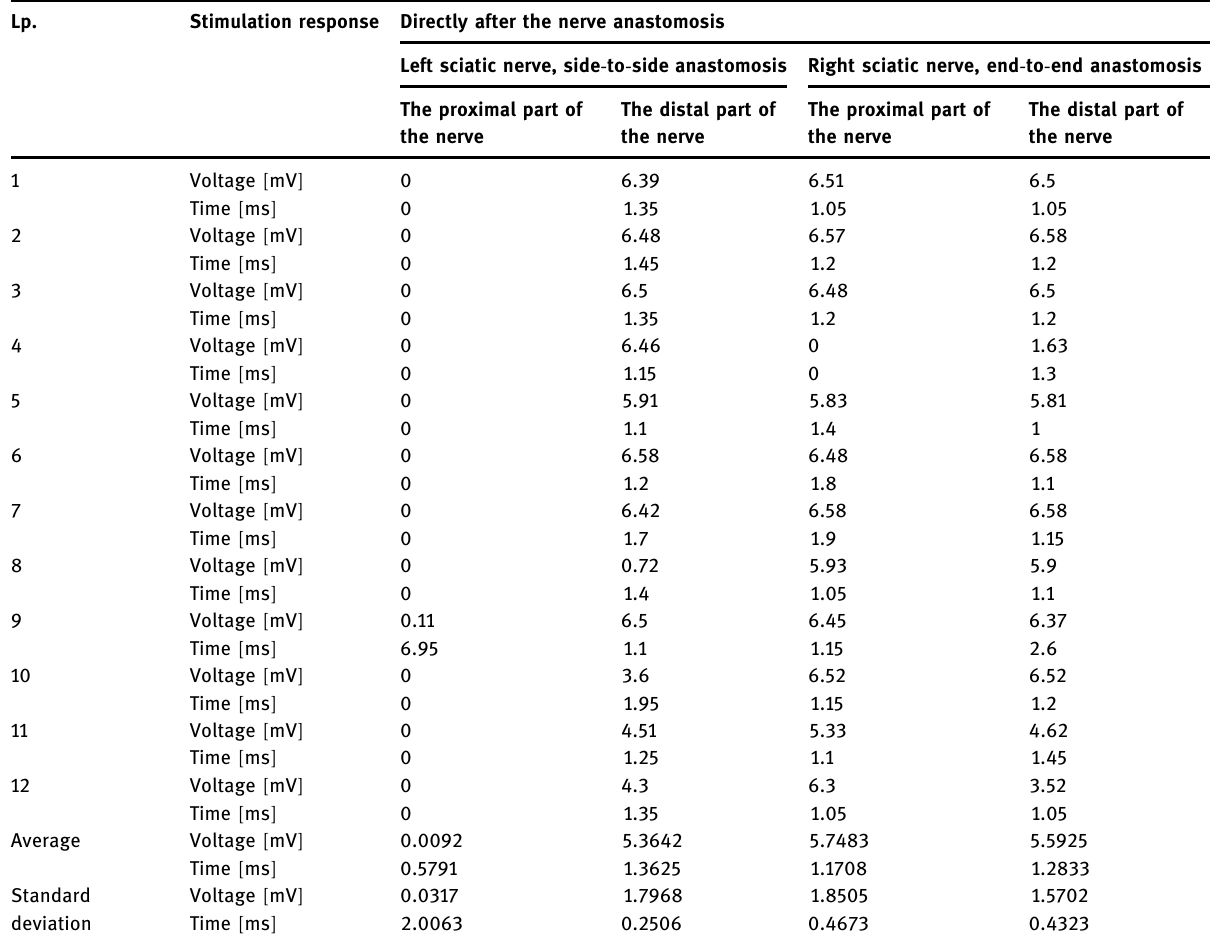
Table 3: Electrophysiological parameters upon stimulating the sciatic nerves shortly after the surgical anastomosis.